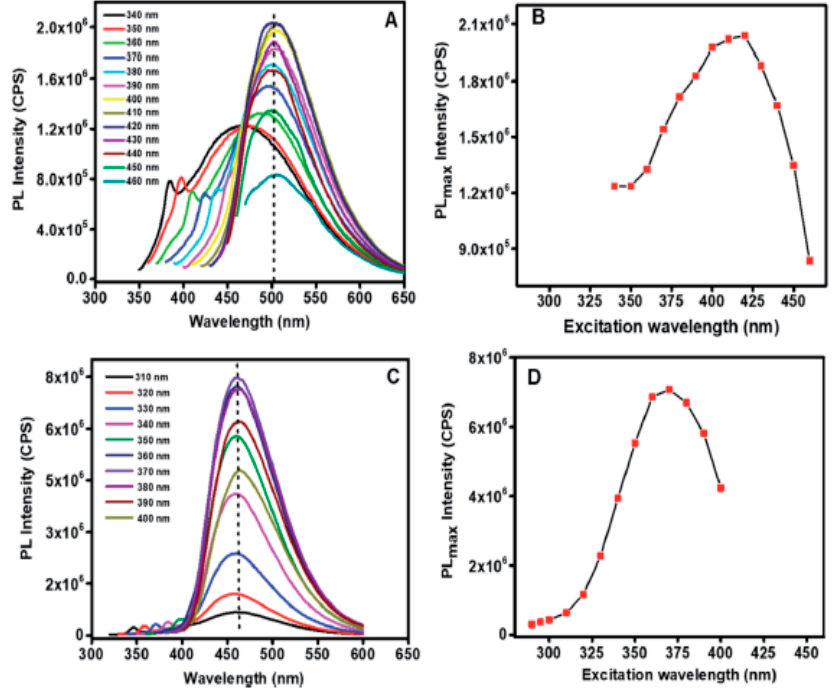
Figure 5. The effect of excitation wavelength on the emission spectra of ( A ) GO-GQDs and ( C ) CA-GQDs. ( B , D ) the effect of excitation wavelength on the maximum PL intensity (PLmax) in each